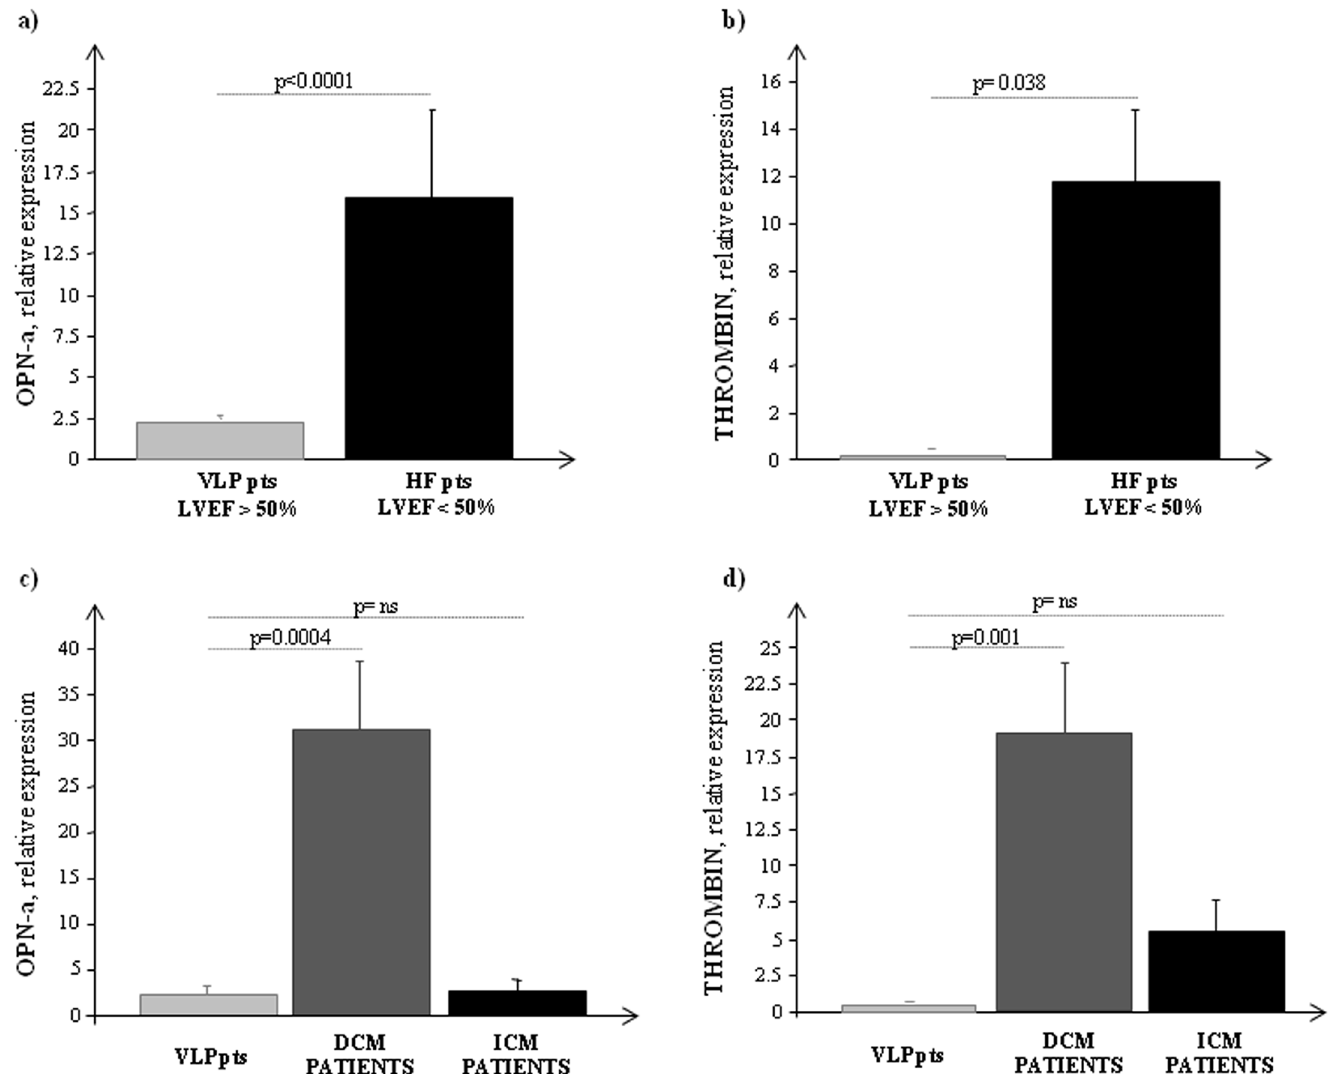
Fig 2. Transcriptional profile of OPN-a and thrombin in all group of patients studied. a) OPN-a and b) thrombin mRNA expression measured by Real Time PCR in VLP patients with LVEF > 50% and HF patients with LVEF < 50%; c) OPN-a and d) thrombin mRNA expression measured by Real Time PCR in VLP patients with LVEF > 50% and HF patients splitting in DCM and ICM. The three most stably expressed genes ( RPL13a , eEF1a , RPS4X ) was used for normalization of mRNA expression results. Fig 5. For each sample the mRNA expression resulted higher with respect to protein concentra- tion mainly in DCM patients.